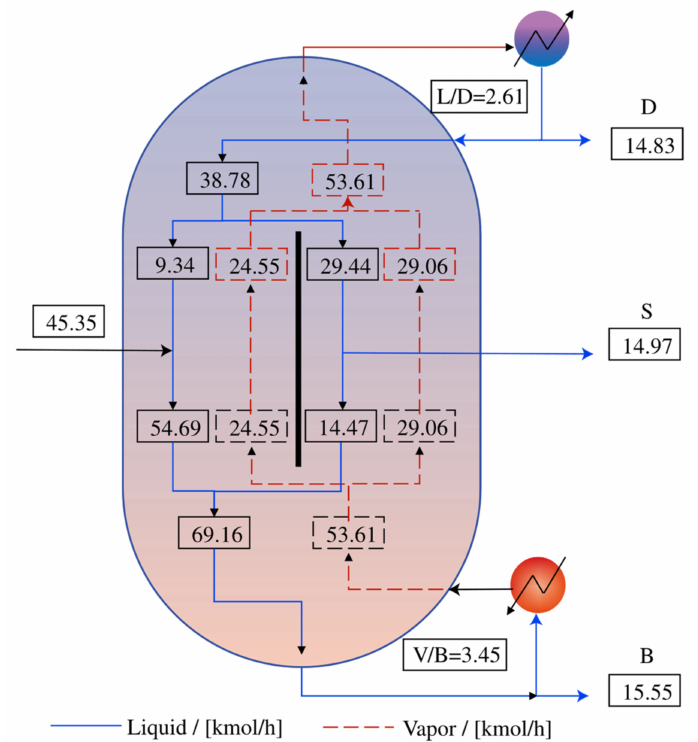
Figure 5. Balance of vapor and liquid in a